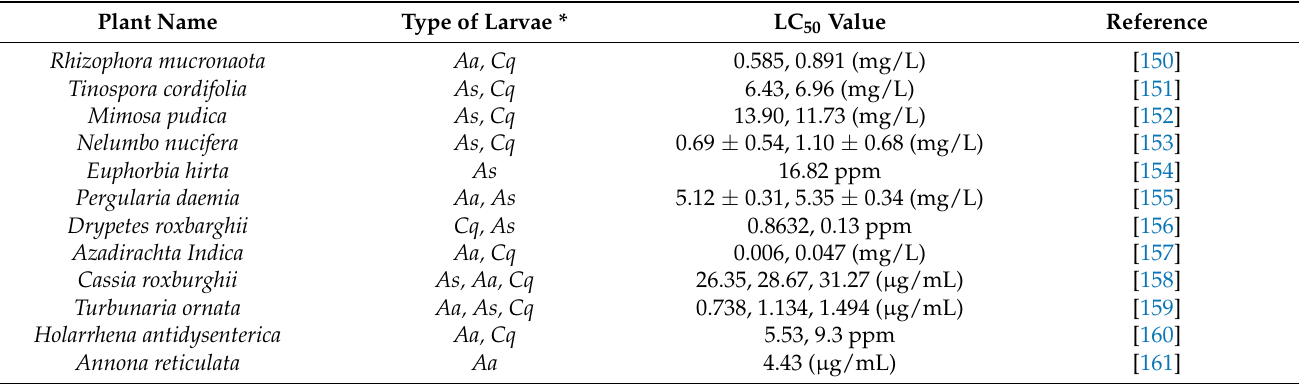
Table 4. Different plant-synthesized AgNPs used for mosquito larvicidal